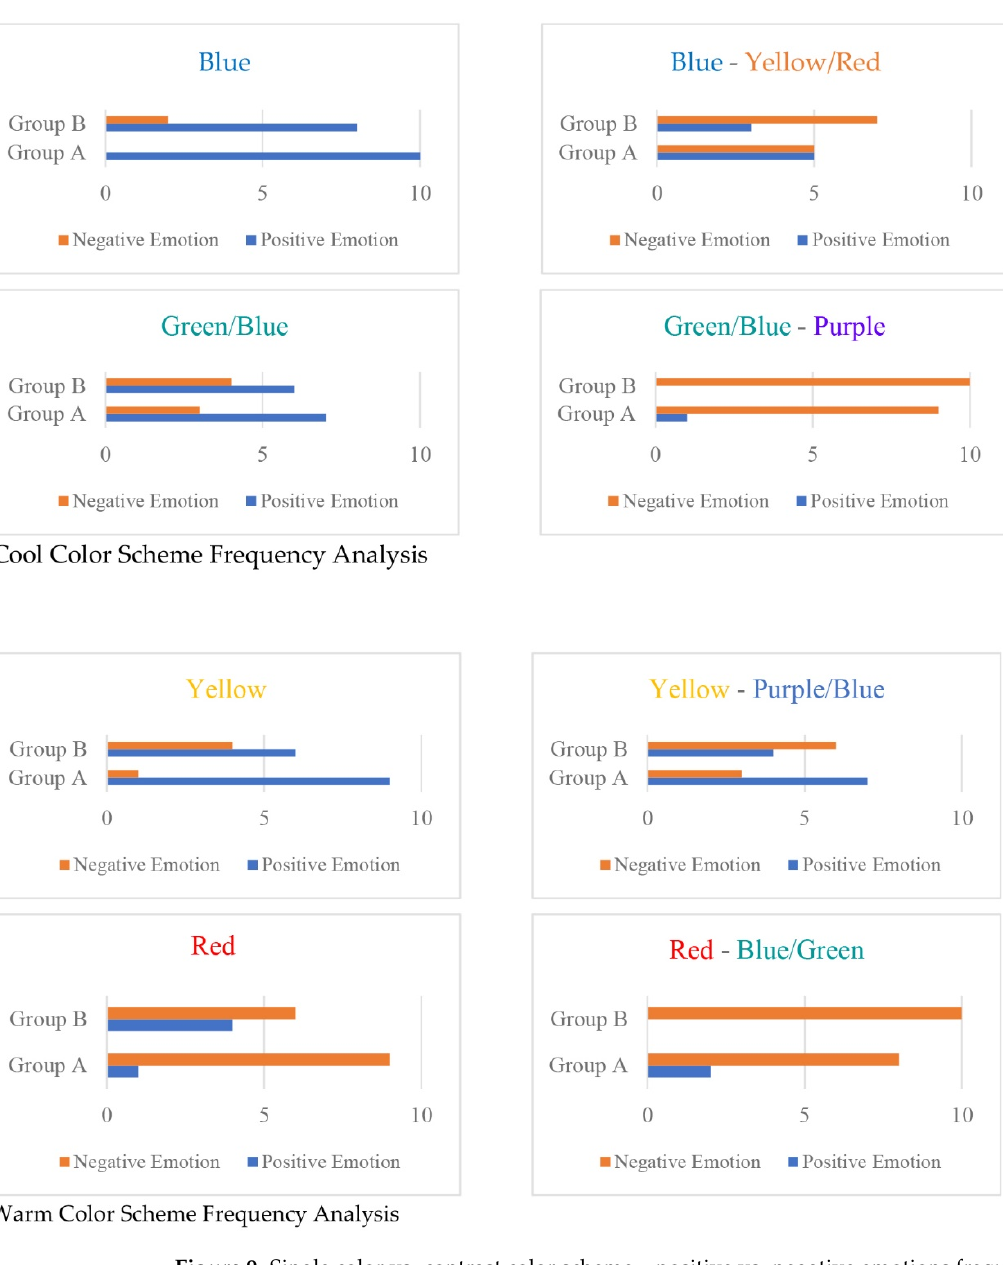
Figure 9. Single color vs. contrast color scheme—positive vs. negative emotions frequency’s analy-